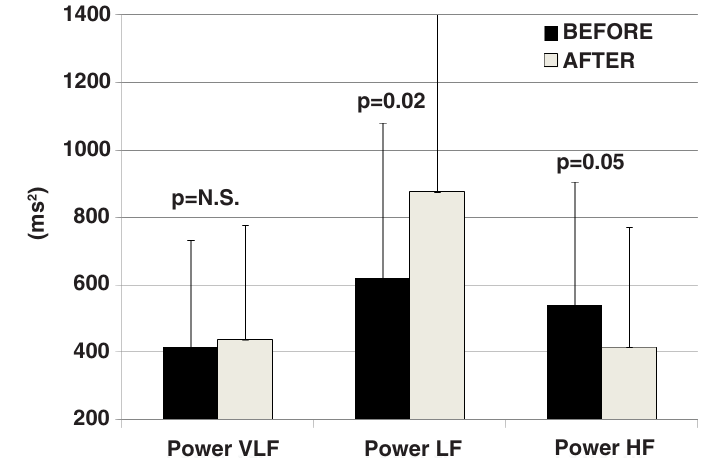
Figure 1. Immediate effects of a single session with Vanquish ® RF treatment in abdominal area on heart rate variability (cumulative spectral power in very low/Power VLF/, low/Power LF/ or high/Power HF/frequency bands): significant increase of predominantly sympathetic (LF) and decrease in parasympathetic (HF) components 20±14min after the treatment.